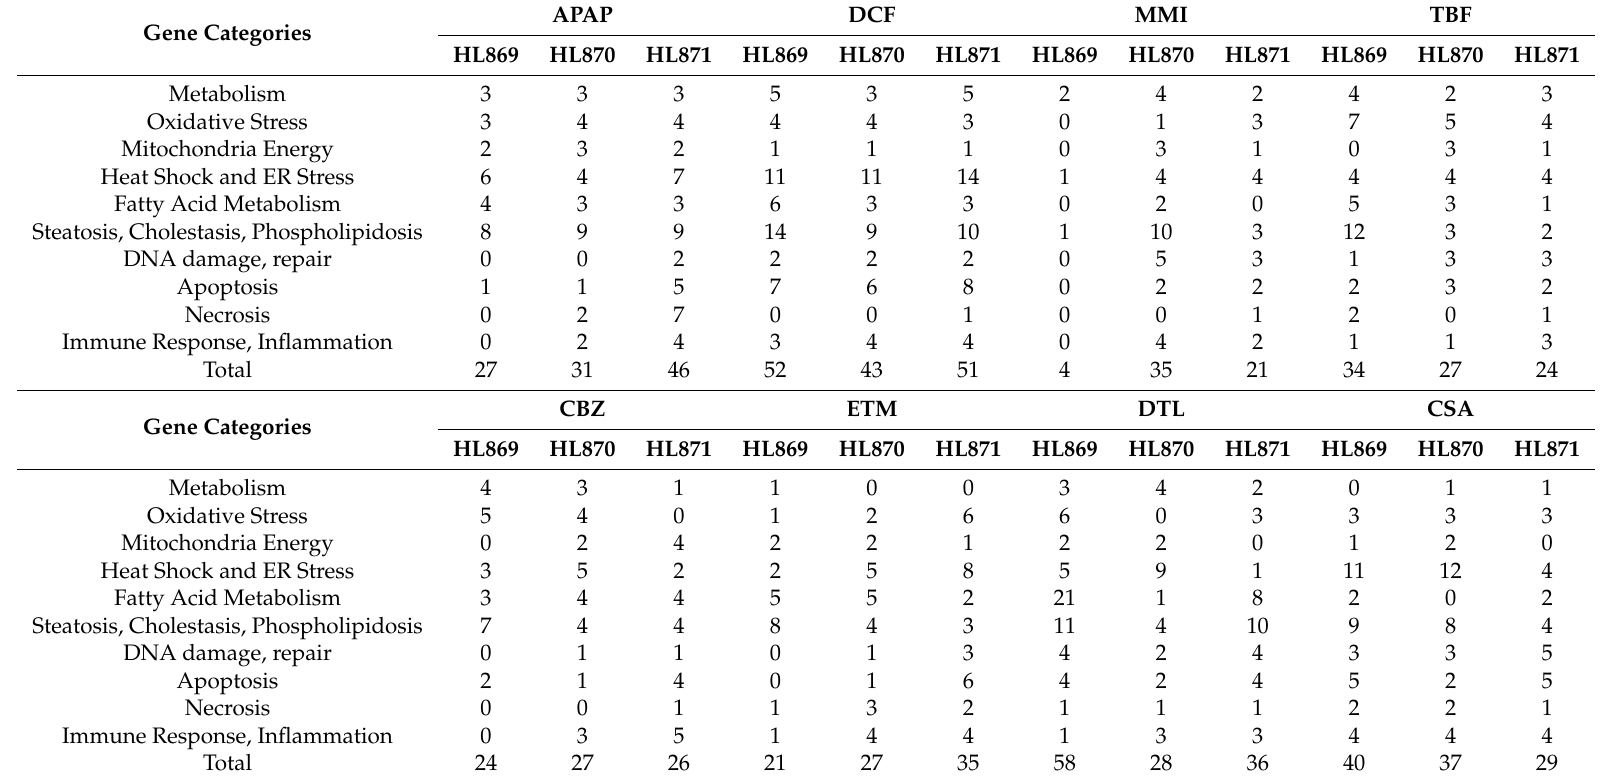
Table 3. Number of significant gene expression changes per category representative of toxicological pathways for each drug and each human liver experiment.